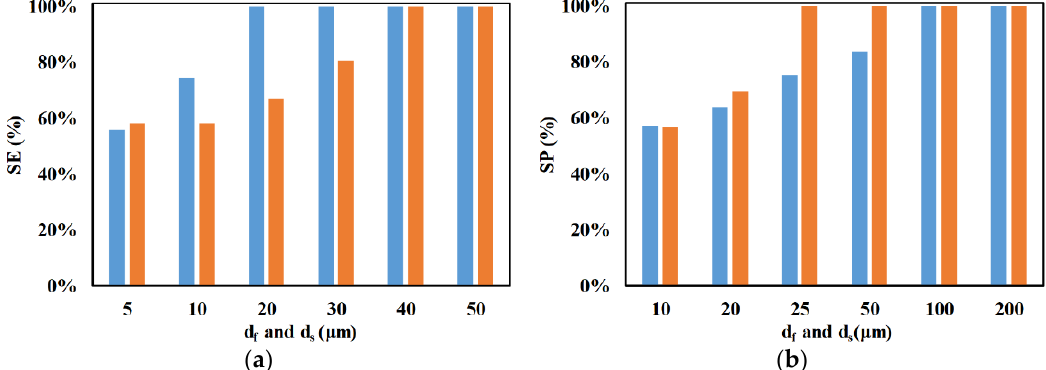
d s = 60 µ m, l s = 120 µ m, V 1 = 3 V pp , V 2 = 15 V pp , V 3 = 15 V pp , V 4 = 3 V pp , H ch = 50 µ m, W ch = 50 µ m). d s = 60 μm, l s = 120 μm, V 1 = 3 V pp , V 2 = 15 V pp , V 3 = 15 V pp , V 4 = 3 V pp , H ch = 50 μm, W ch = 50 μm).